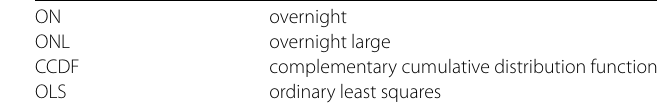
Table 3 List of abbreviations ON overnight ONL overnight large CCDF complementary cumulative distribution function OLS ordinary least